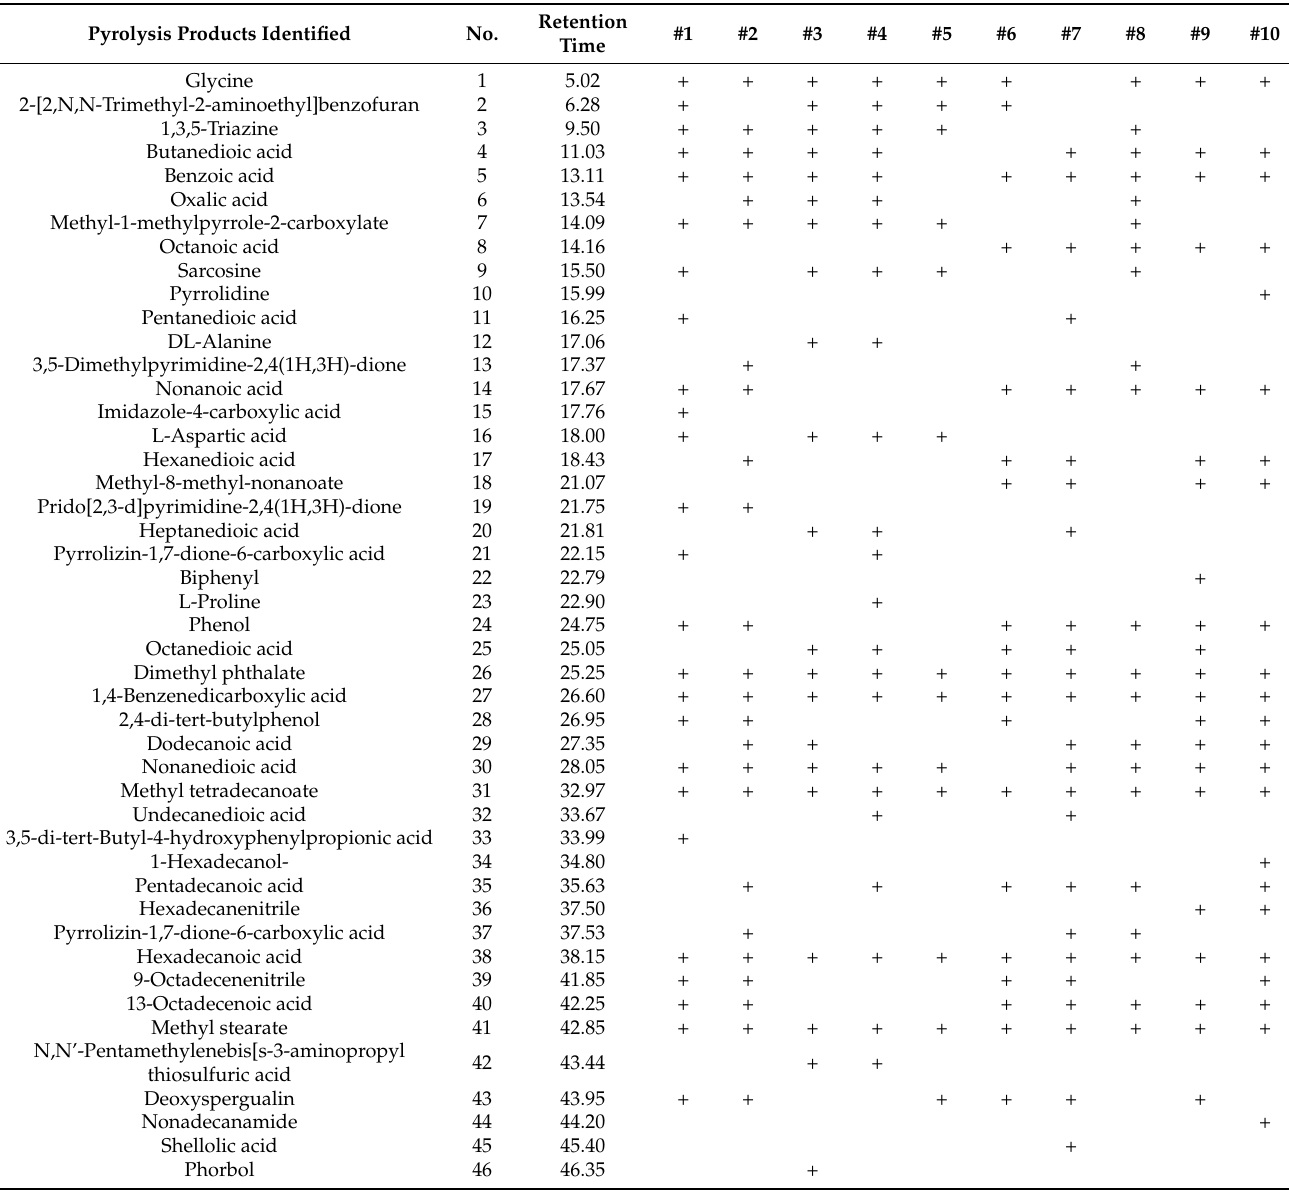
Table 3. Pyrolysis products detected in gilding